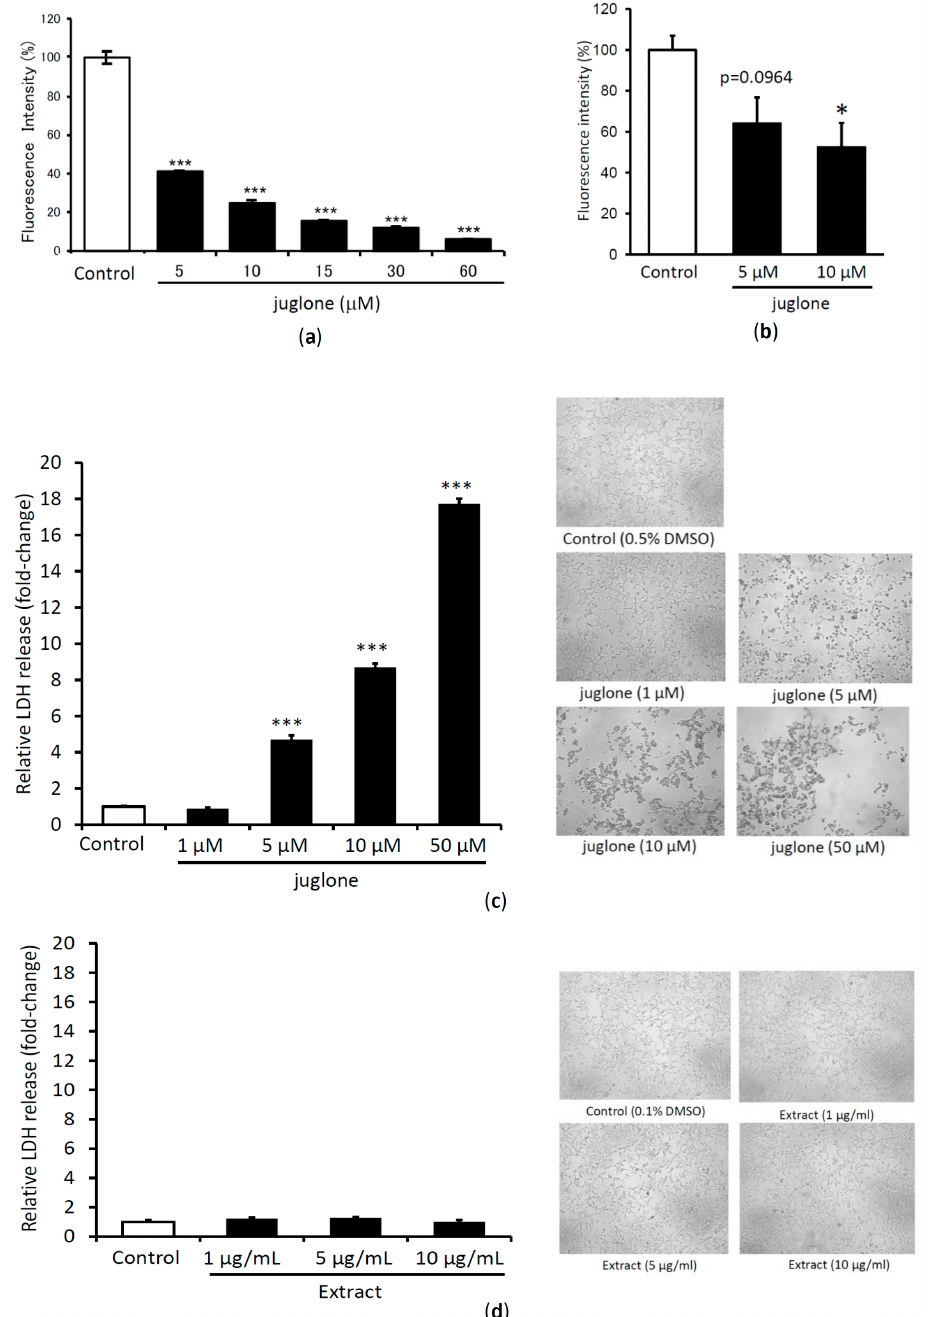
Figure 5. The amyloid fibril disrupting activity of different concentration of juglone when incubated with V30M-TTR tetramer for 24 h and then quantified with Thioflavin T assay ( a ) and PROTEOSTAT ® Protein aggregation assay ( b ). LDH release (left panel) and images of HEK293 cells treated with the different concentration of juglone ( c ) and 50% acetone extract of immature fruits of J. mandshurica var. cordiformis ( d ). Data sets were analyzed by Tukey-Kramer multiple comparison test. * p < 0.05; ** p < 0.01; *** p < 0.001 as compared with control (TTR treated with DMSO in each experiment for ( a , b ), and DMSO for ( c , d )); All experiments were performed in triplicate (means ± SEM, n = 3).